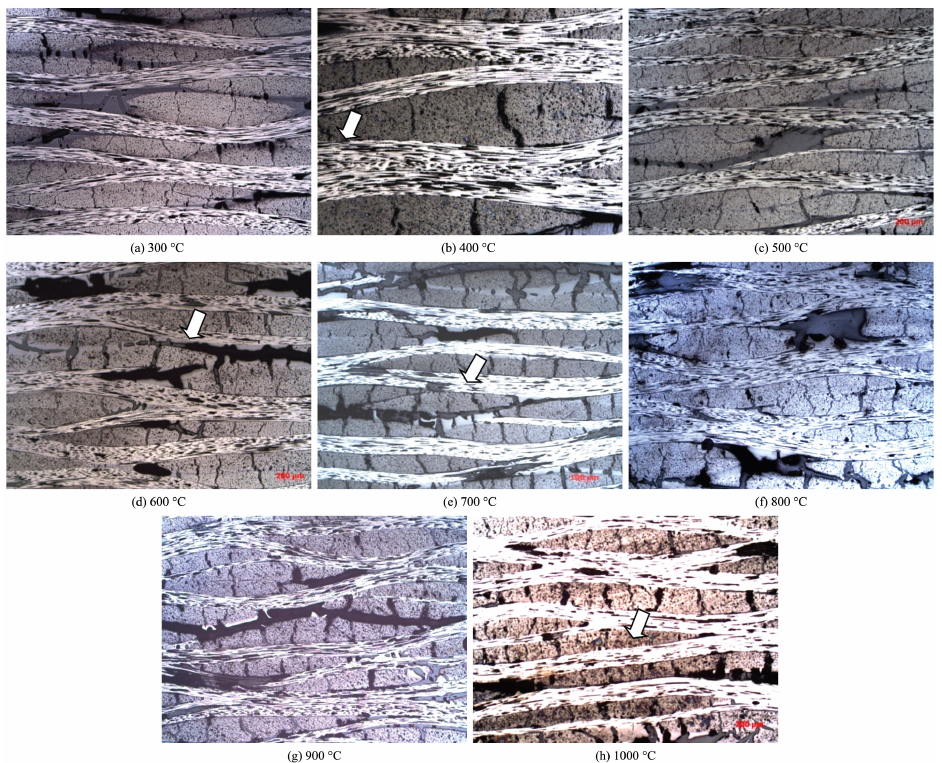
Figure 5. Microstructure of the composites at various stages of heat treatment. The white arrows shown in the micrographs represent microcracks due to delaminations between fabric layers and voids released by thermal degradation (pyrolysis).